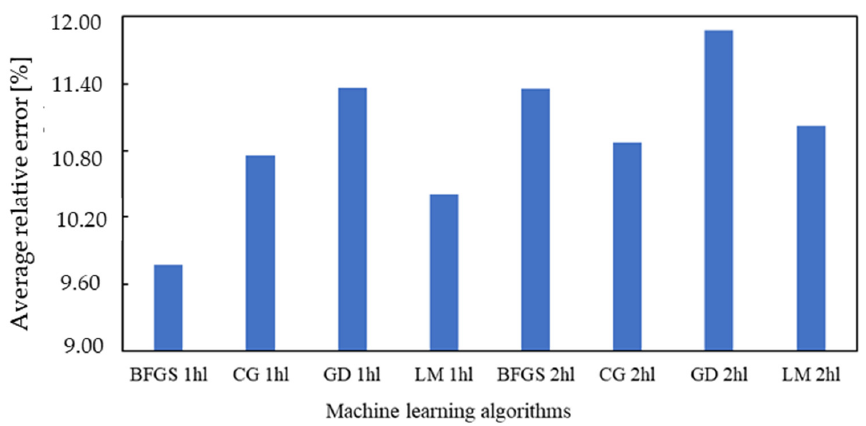
Figure 18. Comparison of models for predicting the pull-off strength of the surface layer f h due to the value of MAPE .